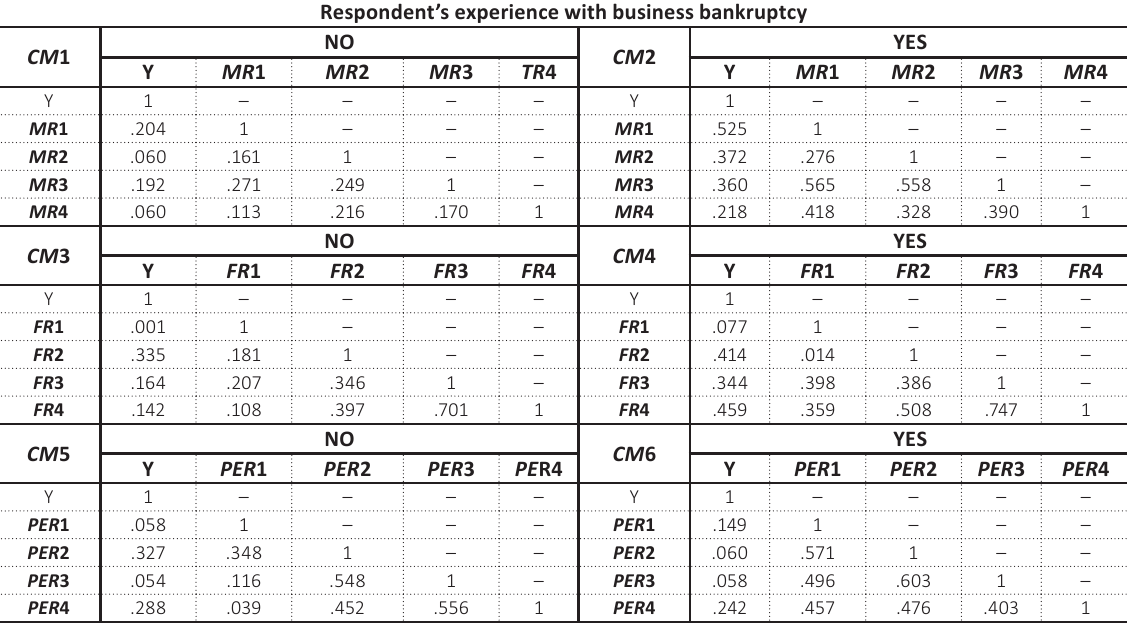
Source: Own research.